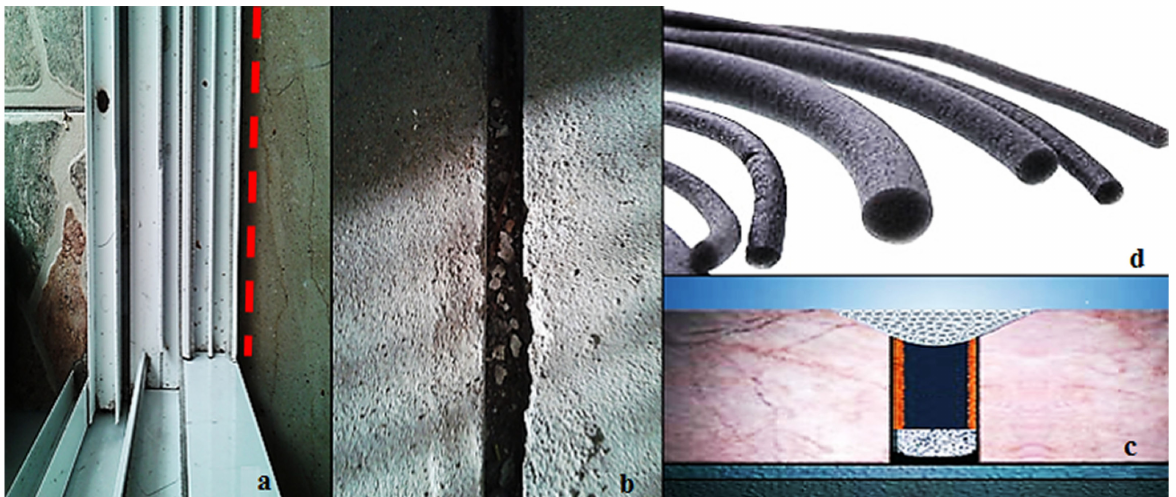
Figure 4. ( a , b ) show the structure line of the insulating barrier: ( a ) focal point of the study area in front of the window; ( b ) construction point for the insulation barrier; and ( c , d ) show the insulation barrier: ( c ) insulation materials; ( d ) insulation barrier on top of the slab, in front of the window base. A better U-value frame was calculated in relation to the barrier that improved the structure materials on the floor. The measurements were taken in January 2017 for three consecutive days, the coldest days of the month in the winter period. The daily mean values of the external weather conditions, internal temperature, and relative humidity are illustrated in a diagram in Figures 5 and